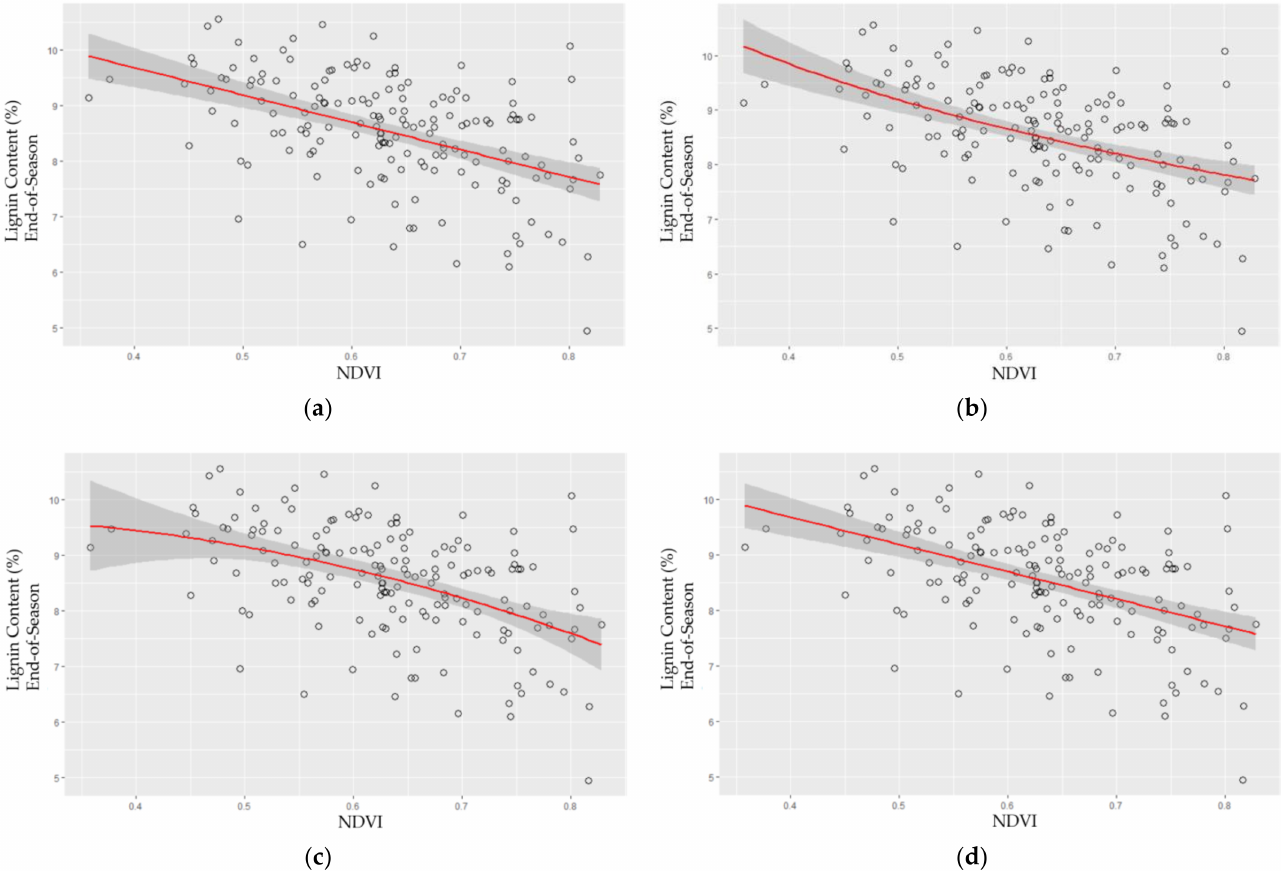
Figure 4. Lignin content model with normalized difference vegetation index (NDVI), ( a ) linear regression, ( b ) logarithm, ( c ) quadratic polynomial, ( d ) Generalized additive model (GAM) at the end-of-season. Note that ( d ) is very similar to ( a ) due to the strong nonlinear effect of the GAM model. X -axis represents the vegetation index (NDVI), and y -axis represents lignin content (%) as determined by near-infrared spectroscopy (NIRS) of field-collected